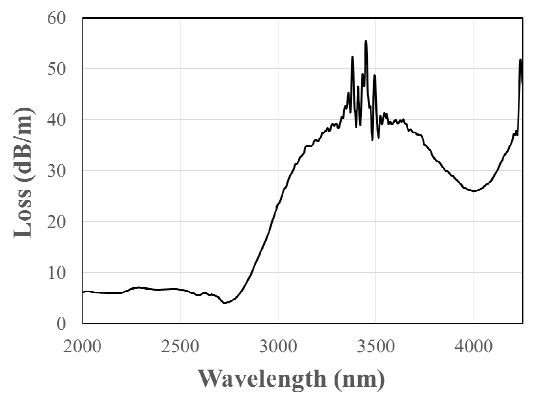
Figure 6. Fabricated fiber loss measured by the cutback method using the Horiba spectrometer with Indium Antimony detector. Indium Antimony